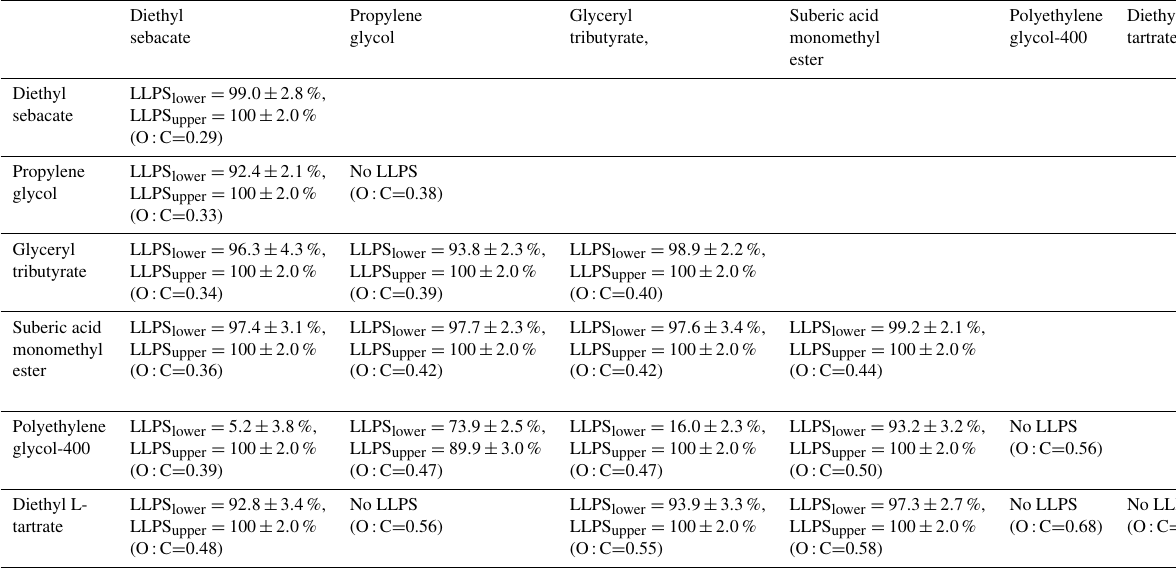
Table 3. Lower RH boundary for LLPS (LLPS lower ) and upper RH boundary for LLPS (LLPS upper ) for particles containing one and two organic species. LLPS lower and LLPS upper represent the lowest and highest RH at which two liquid phases were observed in the experiments. Uncertainties represent 2 σ of multiple measurements and the uncertainty from the calibration. “No LLPS” indicates that only one phase was observed for the full range of relative humidity (RH) explored ( ∼ 0 to 100% RH). Only results are shown here for increasing RH. For particles containing one organic species the O:C of the organic is indicated in brackets. For particles containing two organics, the average O:C of the particles is indicated in